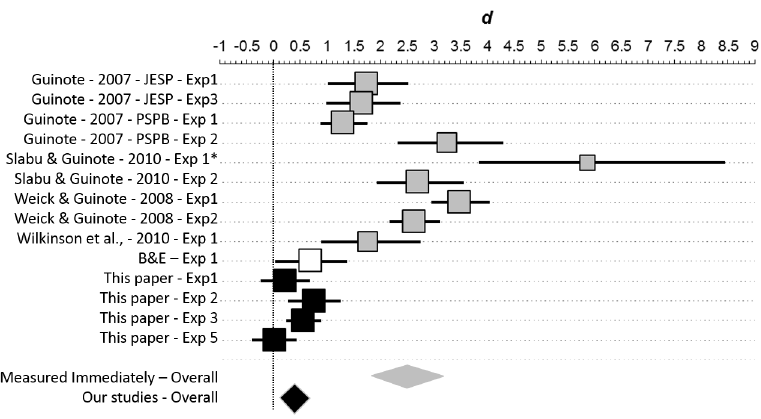
Fig 5. Meta-analysis of the effects of the autobiographical memory task on perceived power. We included our study, Experiment 1 from Burgmer & Englich (2012) (experiment 2 did not contain a perceived- power manipulation check) and all studies we could easily locate which used a perceived power manipulation check after using the autobiographical memory task to manipulate power. For each experiment, the unbiased effect size is represented by a square scaled to reflect proportionate sample size. The 95% confidence interval for the effect size is represented by a horizontal line. Studies colored grey measured perceived power immediately after the manipulation, and their overall effect size is represented by the grey diamond ( d = 2.5, 95% CI [1.9, 3.2]). Burgmer & Englich (Experiment 1, 2012) moved this manipulation check to the end of the study, after the performance measure, and obtained a much smaller effect on perceived power (white square: d = 0.7, 95% CI [0.03, 1.4]). Our studies (shown in black) followed the sequence from Burgmer & Englich (2012). Only our Experiment 5 has an effect size (barely) outside the CI from Burgmer & Englich (2012) and our overall effect size (black diamond) is not radically dissimilar: d = 0.4, 95% CI [0.07, 0.7]. Significant heterogeneity of effect size is evident, even within the restricted set of studies that conducted the manipulation check immediately after the manipulation ( Q (8) = 63.5, p < 0.009). All effect sizes from prior literature were calculated based on reported t and df values. This figure was generated with the Meta- Analysis module in the Exploratory Software for Confidence Intervals package for Microsoft Excel (Cumming, 2012). * In Slabu & Guinote (2010) Experiment 1 reports “ t(17) = 127.41 ” , which yields d = 61.8. The summary data reported, however, are consistent with an effect size of about 6.1. We suspect, then, that the t value provided had a decimal place transposed, and used t (17) = 12.74, yielding d = 6.18. We used this more plausible value in this meta-analysis. Note, though, that even this value stands out as an exceptionally strong effect relative to other studies reported in the